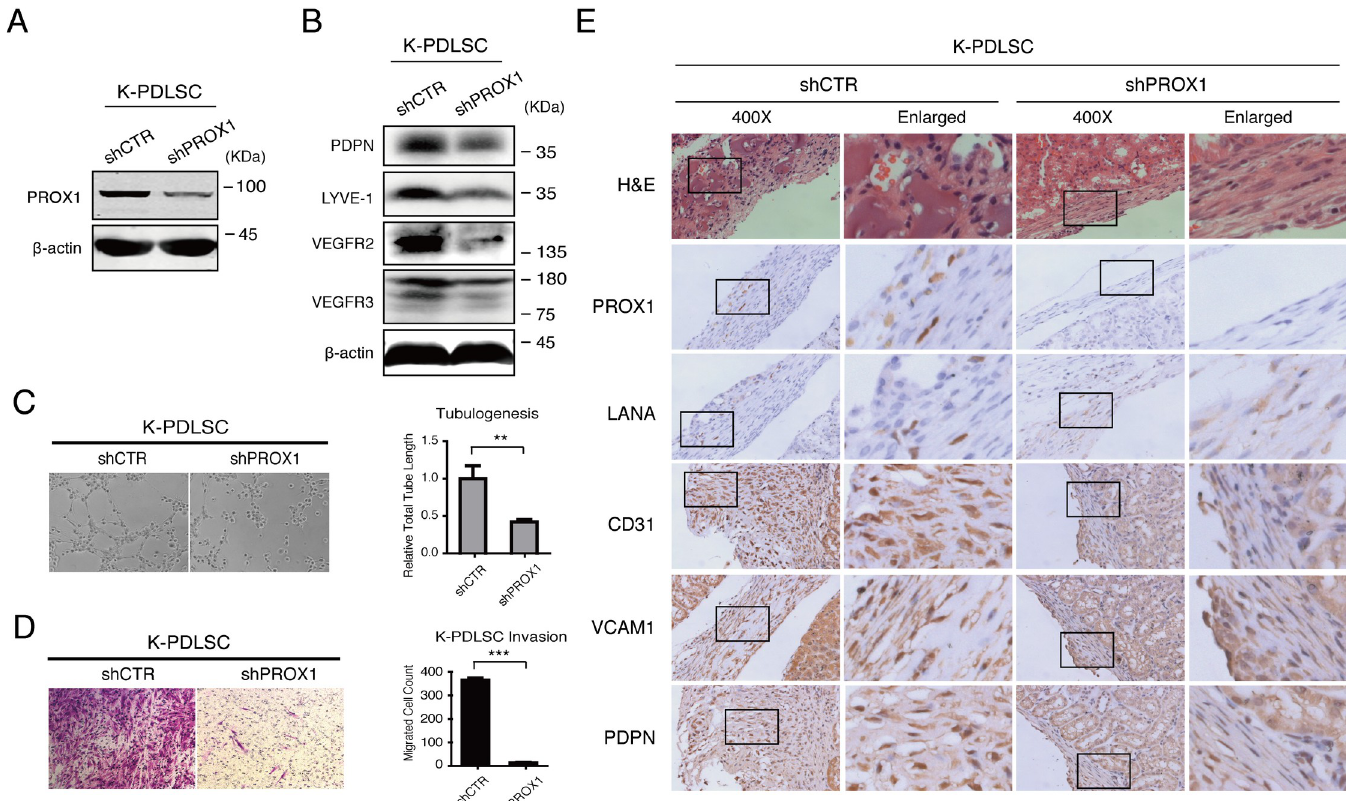
Fig 2. The critical role of PROX1 in mesenchymal-endothelial transition induced by KSHV. An shRNA lentivirus specific to PROX1 (shPROX1), along with a control shRNA (shCTR), were transduced into PDLSCs, followed by infection with KSHV. (A) The efficiency of PROX1 silencing was verified by Western blot. (B) The effects of the shRNA on the expression of pan-endothelial and lymphatic endothelial markers VEGFR2, LYVE-1, PDPN, and VEGFR3 were examined by Western blot. (C) KSHV- infected PDLSCs (K-PDLSC) transduced with shPROX1 or shCTR were evaluated for endothelial differentiation and angiogenic activities through a tubule formation assay. (D) K-PDLSCs transduced with shPROX1 or shCTR were subjected to cell invasion assay to determine the effect of PROX1 silencing on cell migration and invasion ability of K-PDLSCs. (E) KSHV-PDLSCs transduced with shPROX1 or shCTR were implanted under the kidney capsule of immunocompromised mice for 28 d. Then the kidney capsule was taken out and analyzed by hematoxylin and eosin (H&E) and IHC (PROX1, LANA, CD31, VCAM1, and PDPN) staining.